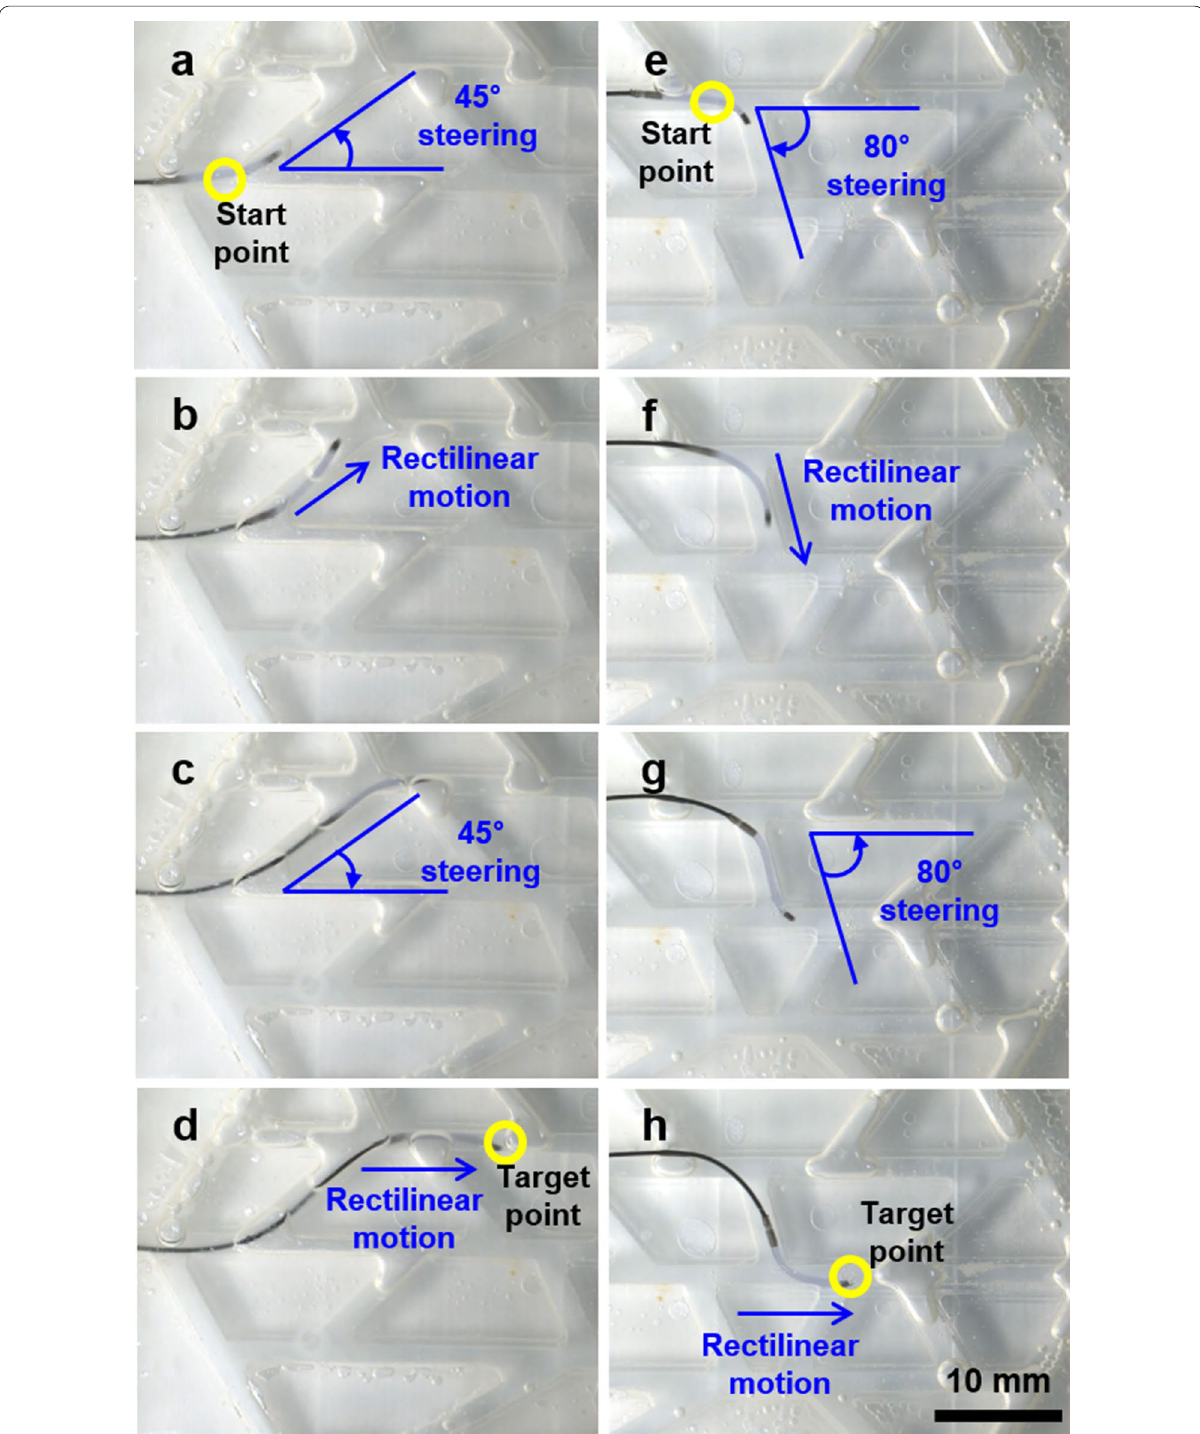
Fig. 9 Tracking of the flexible microrobot in a two‑dimensional phantom with various branches. a , c magnetic steering at 45°; b , d manual rectilinear motion imparted by pushing the guidewire; e , g magnetic steering at 80°; and f , g manual rectilinear motion imparted by pushing the guidewire. Additional file 1 shows the